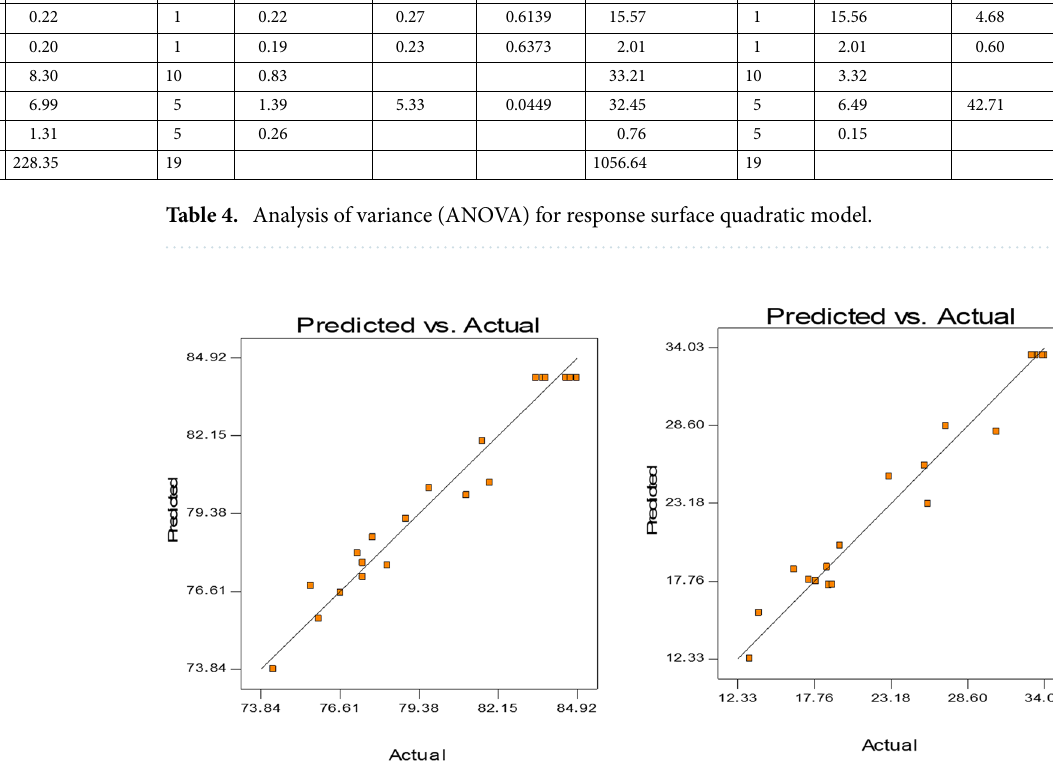
Figure 5. Predicted vs actual values curve for antioxidant activity and TPC of F. auriculata fruit